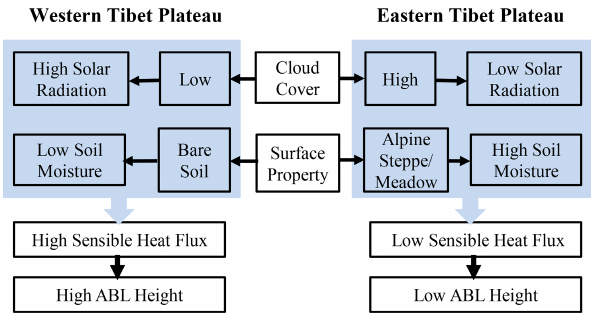
Figure 13. The schematic diagram for relationships between the ABLH and the influential factors in the ETP and the